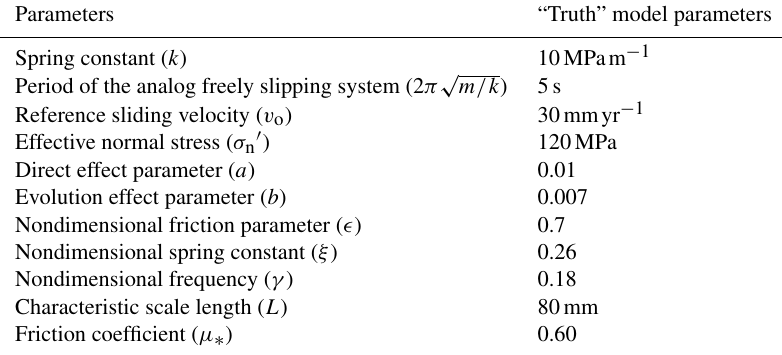
Figure 2. Phase diagram for a Burridge–Knopoff (BK) model with a rate-and-state friction formulation when (1) (cid:15) = 0.72 (a small-bias case), (2) (cid:15) = 0.60 (an intermediate-bias case), (3) (cid:15) = 0.40 (a large-bias case) and (4) the model parameter is equal to the true parameter (a case of no bias). Table 1. Parameters of the reference